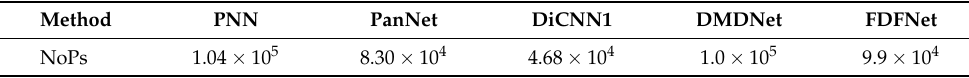
Table 9. The number of parameters (NoPs) of DL-based